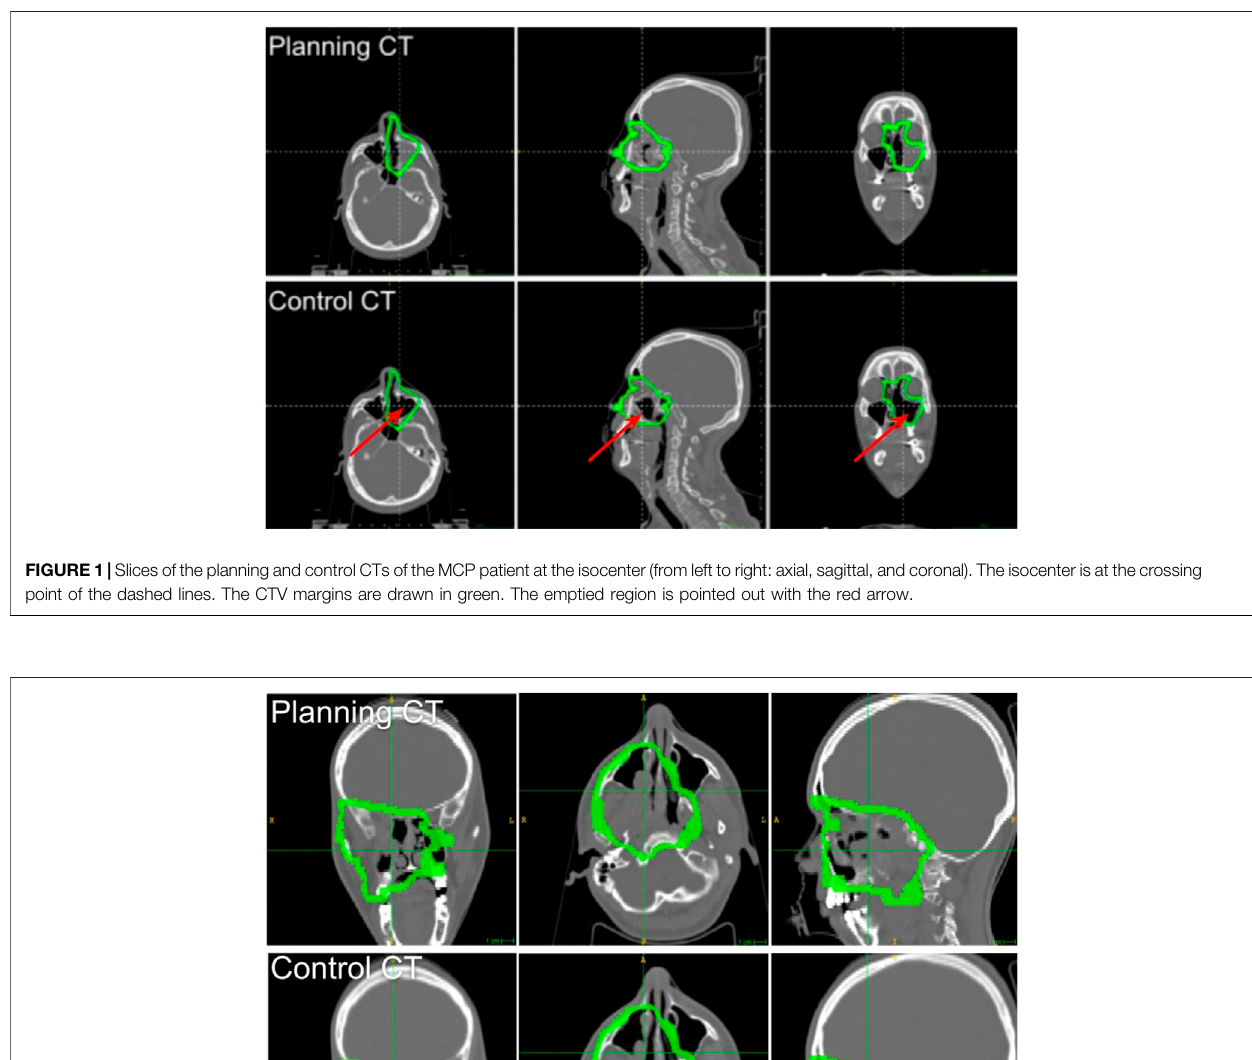
Frontiers in Physics |